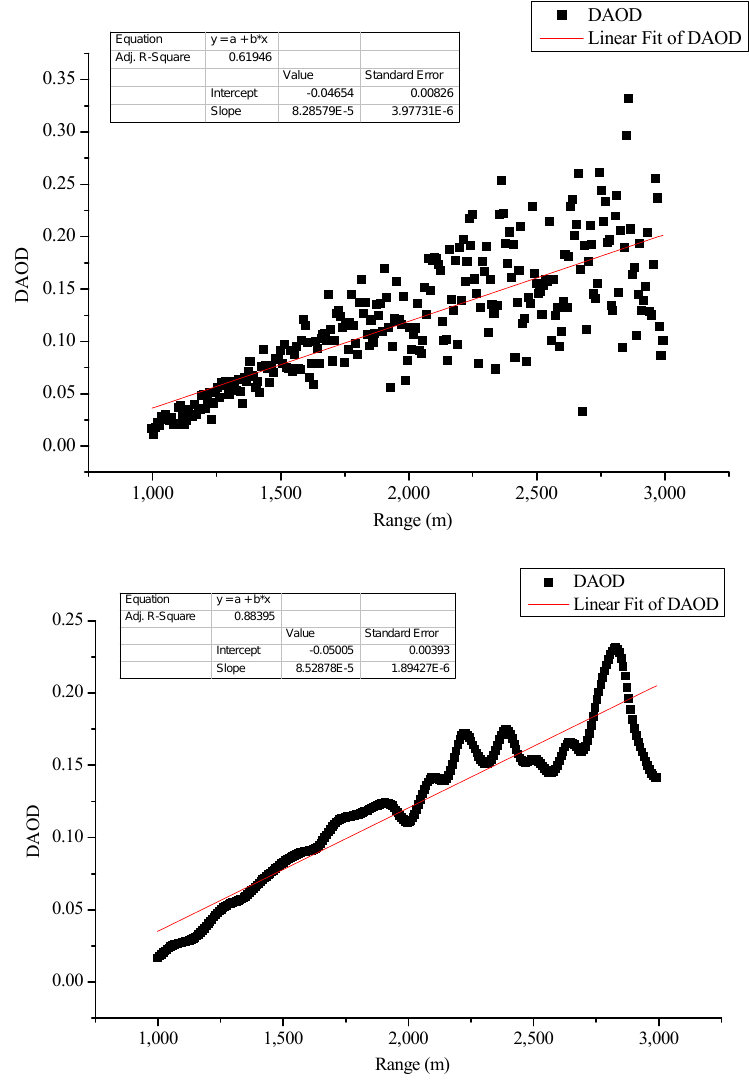
Figure 19. Calculated DAOD of the signal after denoising via LWT. The above is the DAOD of original signal, and the below is the DAOD of denoised signal via LWT. Table 3. Linear fitting parameters of the original and denoised signals. Table 3. Linear fitting parameters of the original and denoised